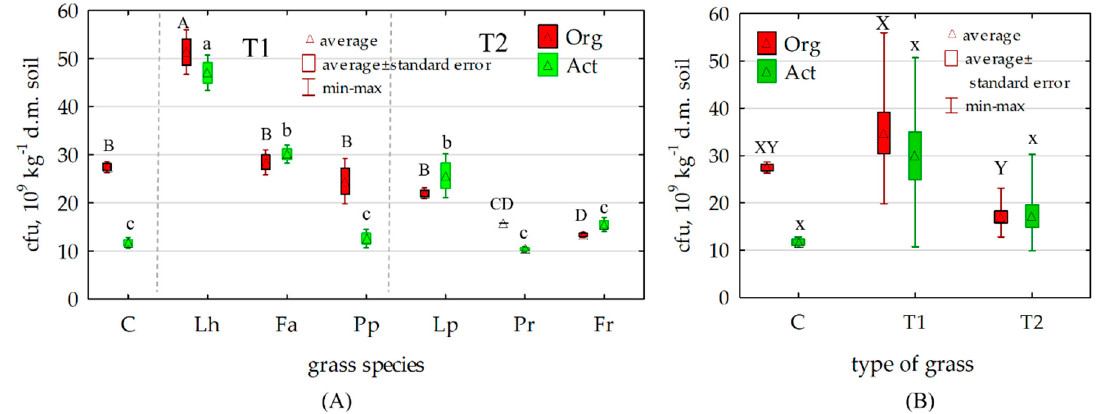
Figure 2. Count of soil organotrophic bacteria (Org) and actinobacteria (Act), cfu 10 9 kg − 1 d.m. of soil: ( A ) depending on the species of grass, ( B ) depending on grass type (fodder or lawn). Homogeneous groups denoted were calculated separately for each microorganisms, groups denoted with letters (a–d) were calculated for the species of grass and groups denoted with letters (x–y) were calculated for the type of grass. C—unsown soil; Lh— Lolium x hybridum Hausskn; Fa— Festuca arundinacea ; Pp— Phleum pratense , Lp— Lolium perenne , Pr— Poa pratensis ; Fr— Festuca rubra.